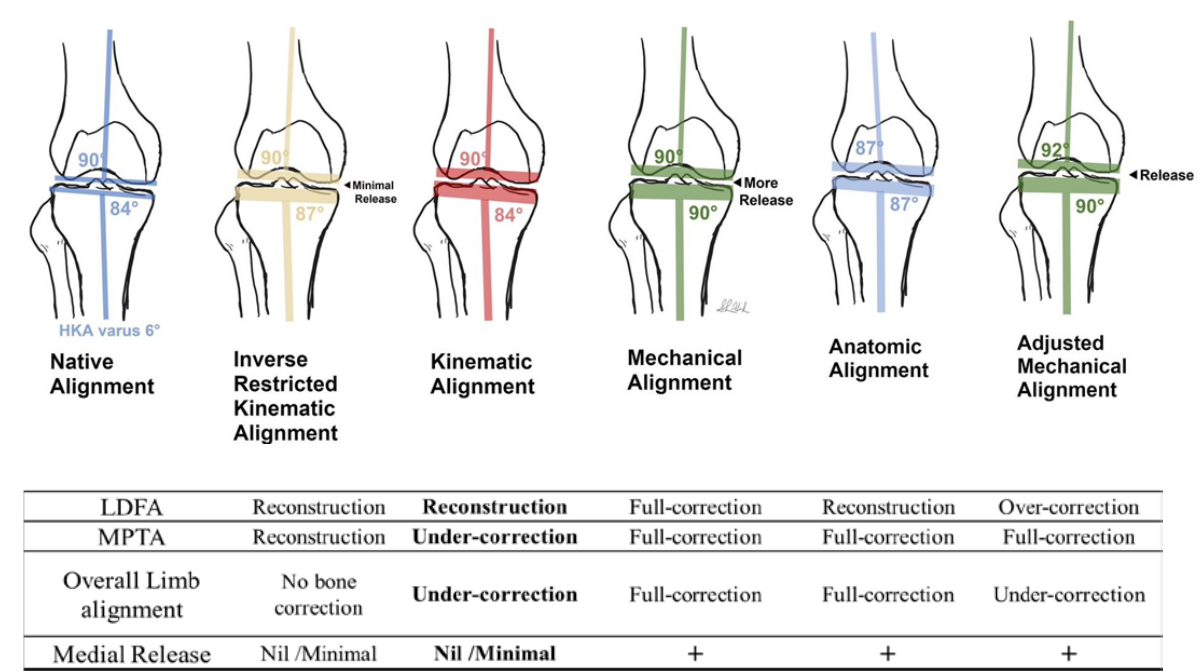
Figure 4. Comparison of different techniques for TKA coronal aligning. From left to right, native knee, inverse restricted KA (irKA), kinematic alignment (KA), mechanical alignment (MA), anatomical alignment (AA), adjusted mechanical alignment (aMA). The irKA technique restores alignment through combined tension gap-balanced and measured resection technique based on native tibia vara (within 6.2°HKA), reducing the need of soft-tissue release. “+”, means with medial release.